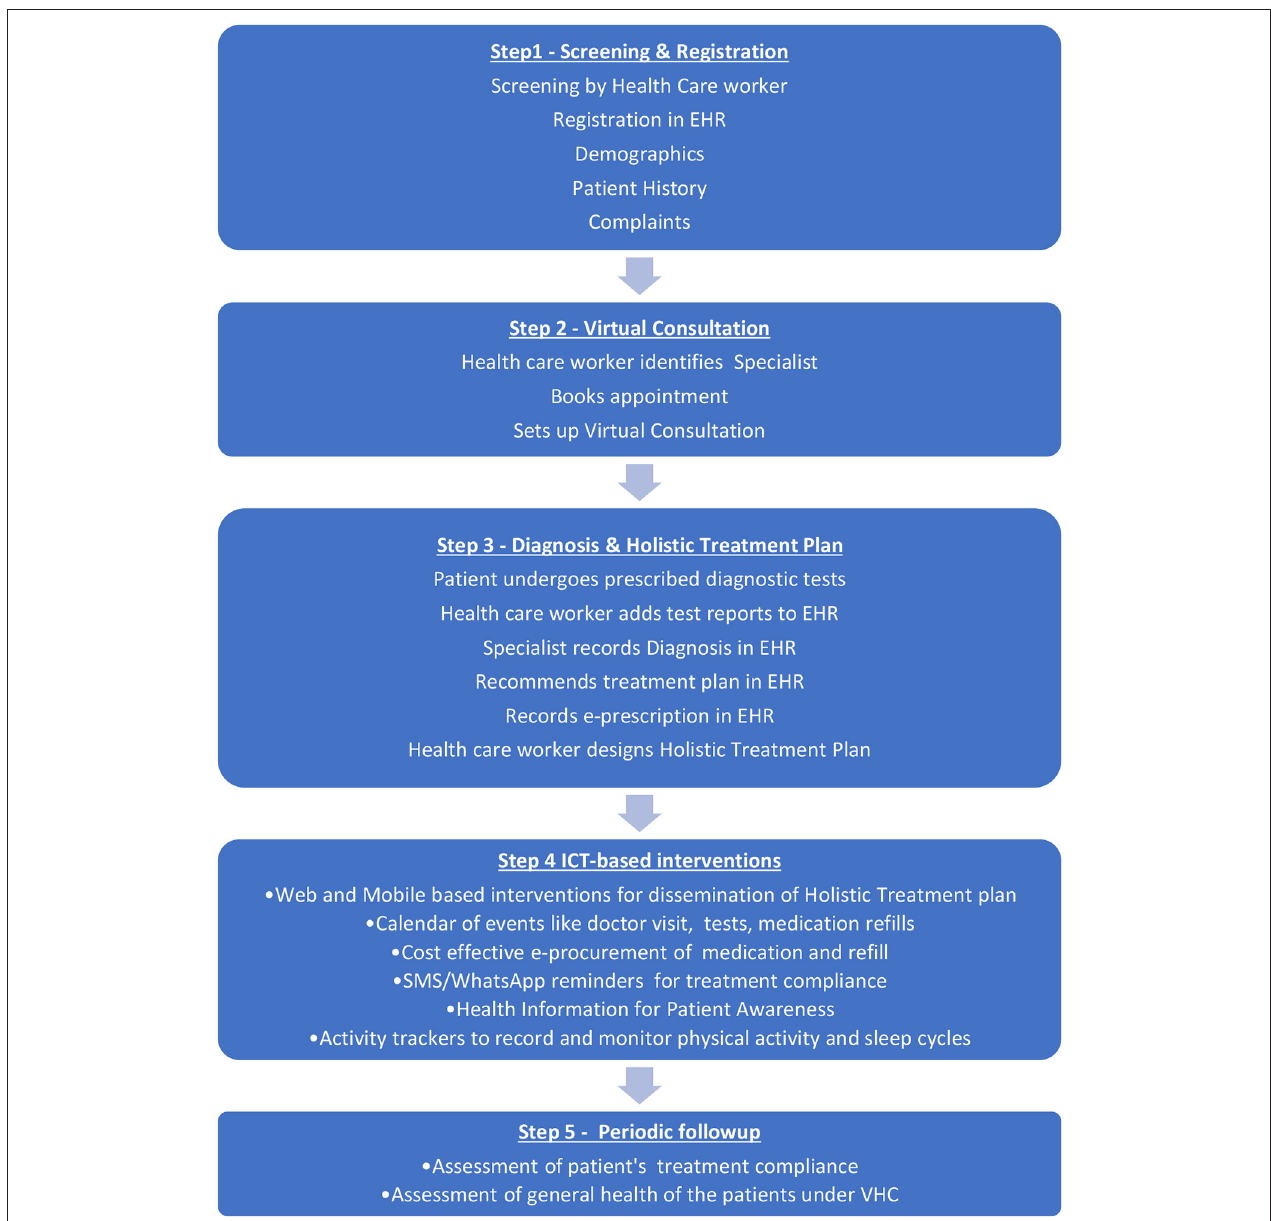
FIGURE 2 | The proposed Approach for Goal 1 and O.1.1 to O.1.4 Concept (Source PAHO,